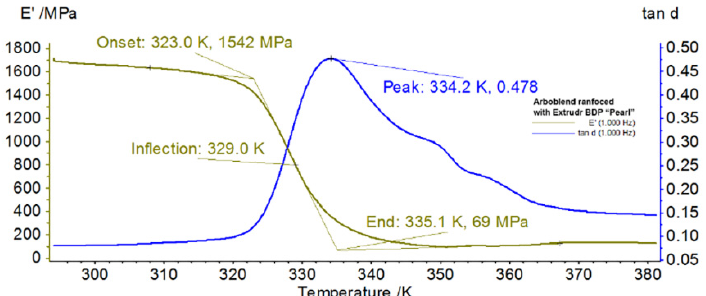
Figure 8. Dynamic Mechanical Analysis ( DMA) thermogram recorded during heating of Arboblend V2 Nature reinforced with Extrudr BDP “Pearl”.